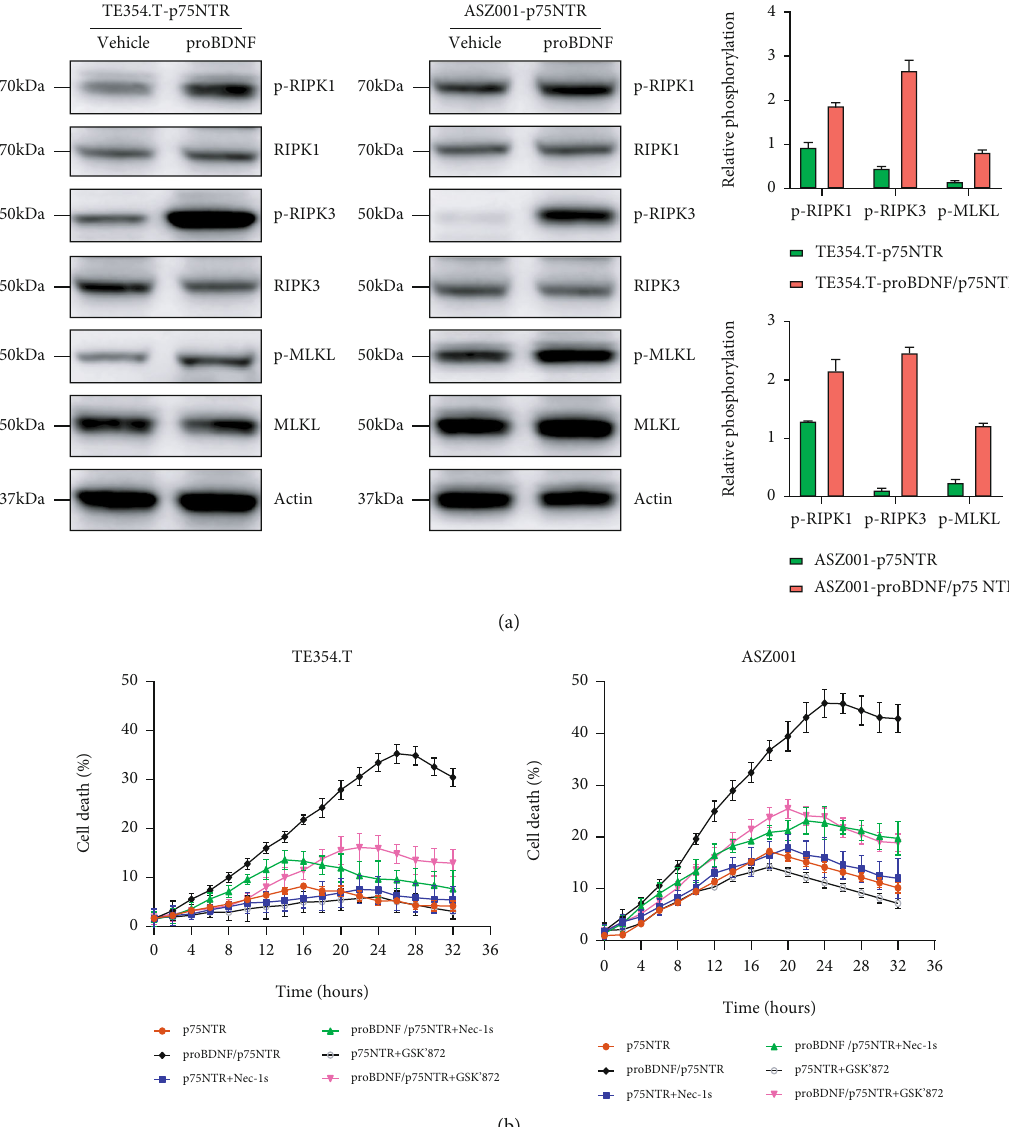
Figure 3: p75NTR/proBDNF controls RIPK1/RIPK3-induced necroptosis. (a) Western blot analysis of p-RIPK1, p-RIPK3, and p-MLKL protein levels inTE354.T-P75NTR and ASZ010-p75NTR cells treated with or without proBDNF plus 20 ng/mL TNF. (b) TE354.T- P75NTR and ASZ010-p75NTR cells stabilized expressed with fused GFP were treated with or without proBDNF plus 20ng/mL TNF. Necroptotic cell death was monitored by staining with cytotoxic red and monitored by